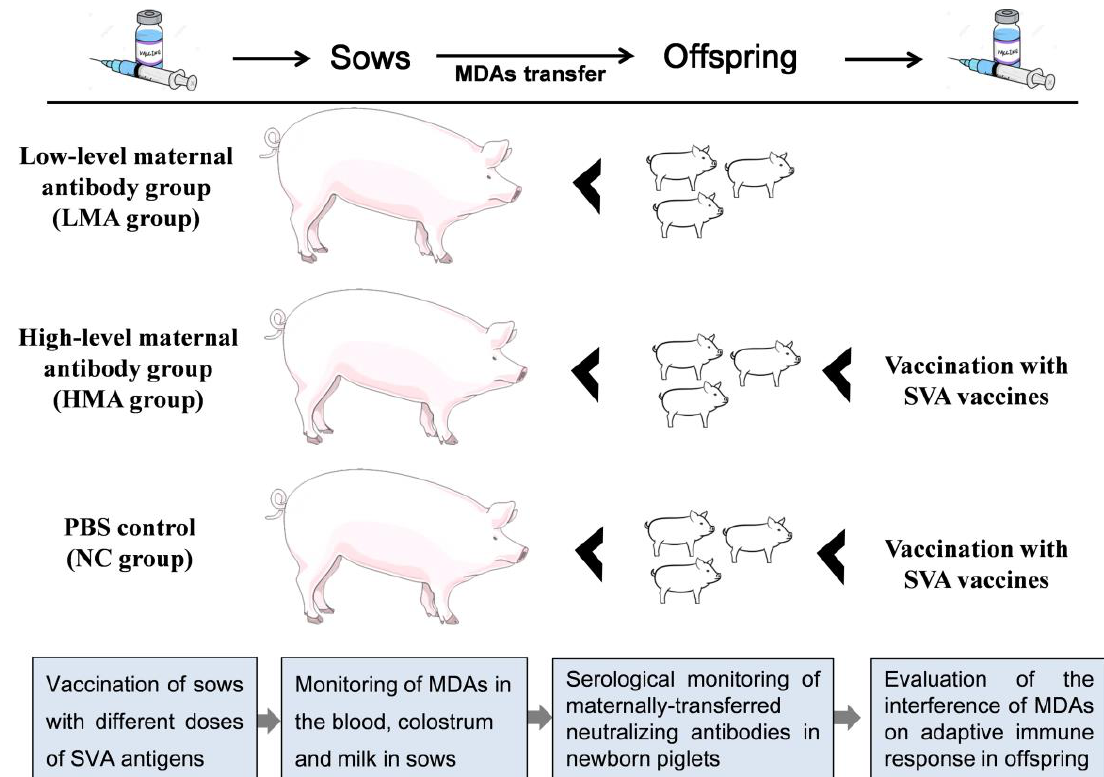
Figure 1. Schematic representation of the experimental design in this